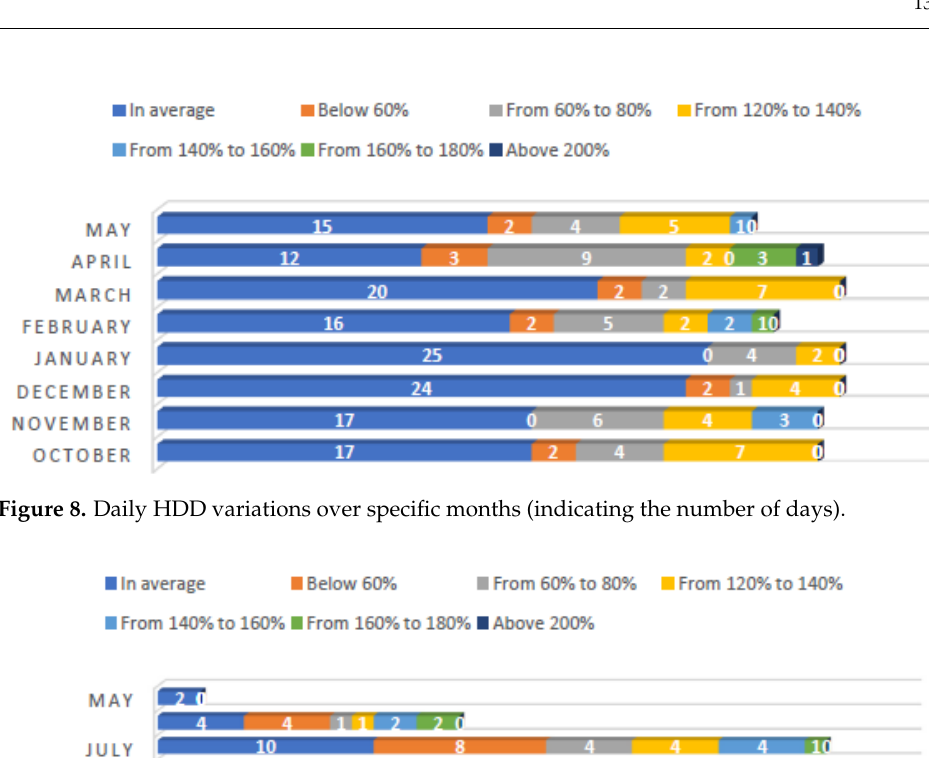
Figure 7. Baseline energy consumption for cooling.